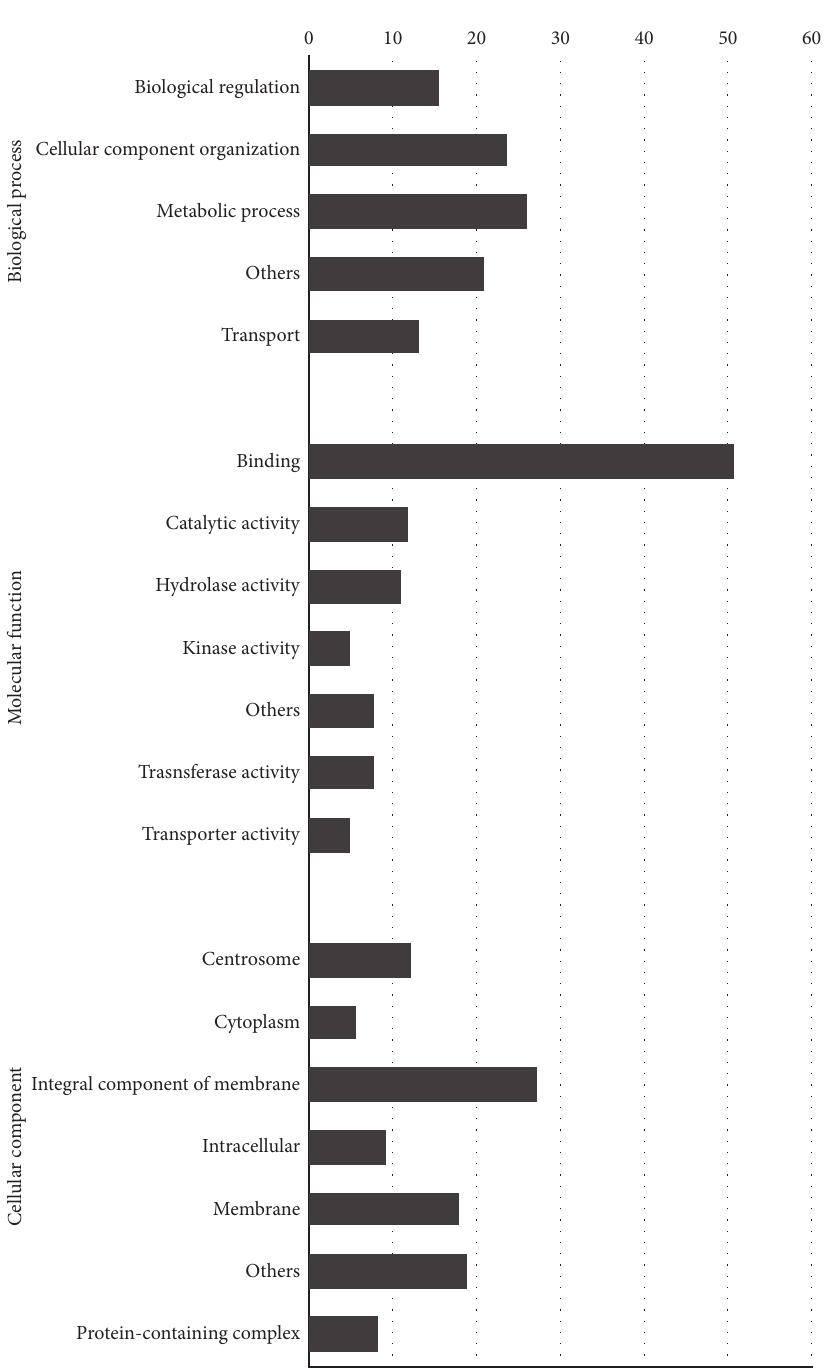
Figure 5: Percentage representation of GO enrichment analysis of shared lncRNA targets in S. mansoni and S. haematobium